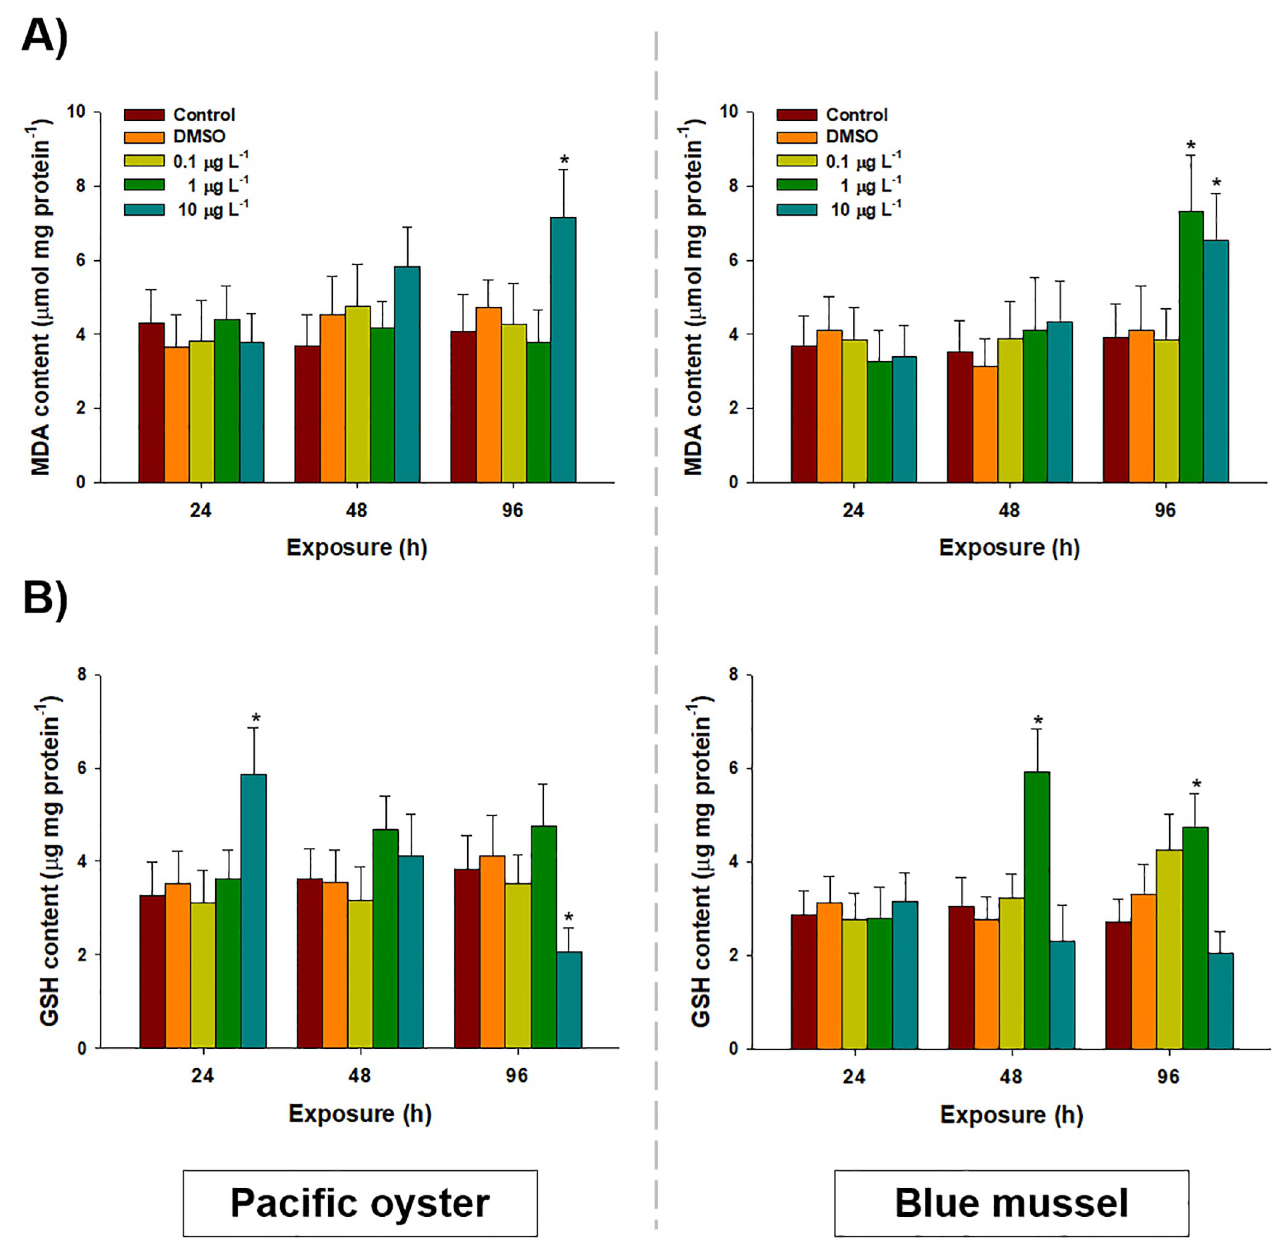
Fig 1. Effects of waterborne chlorothalonil on non-enzymatic oxidative stress parameters of marine bivalves. Effects of different concentrations of chlorothalonil (0.1, 1.0, and 10.0 μ g L -1 ) on (A) malondialdehyde (MDA) and (B) glutathione (GSH) levels in the gill tissues of Pacific oyster ( Crassostrea gigas) and blue mussels ( Mytilus edulis) for 96 h. Lipid peroxidation measured by TBARS. Data are expressed as the mean ± standard deviation (S.D.). An asterisk ( � ) indicates significant differences compared to the control ( P < 0.05).